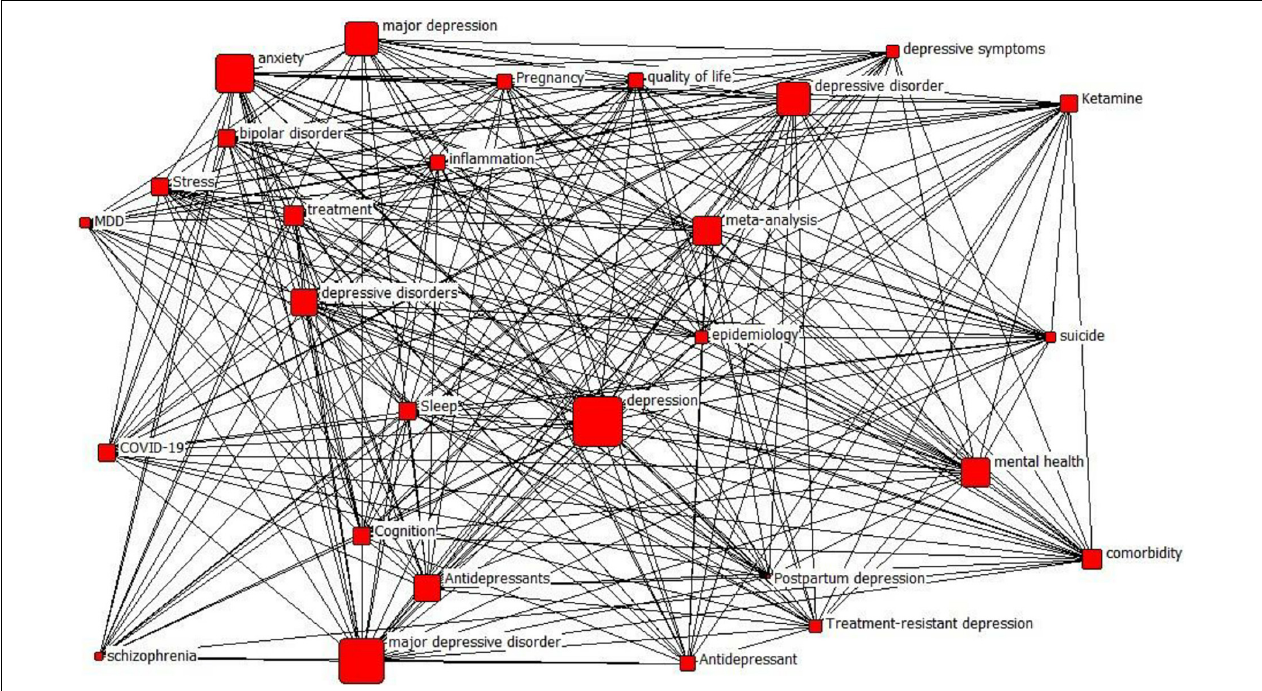
FIGURE 6 | Mediated centrality of layer 3